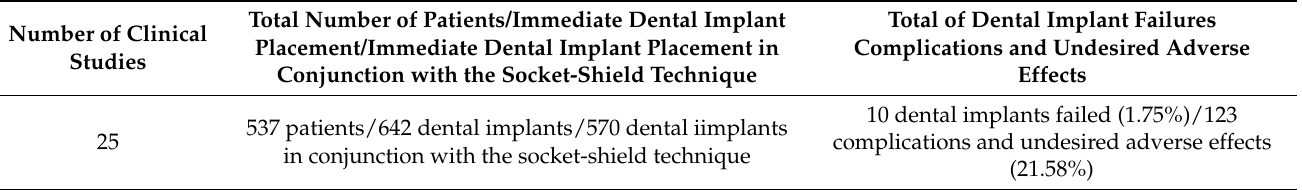
Table 3. The quantitative description of the total number of clinical studies included in the present and complications in conjunction with the socket-shield technique.